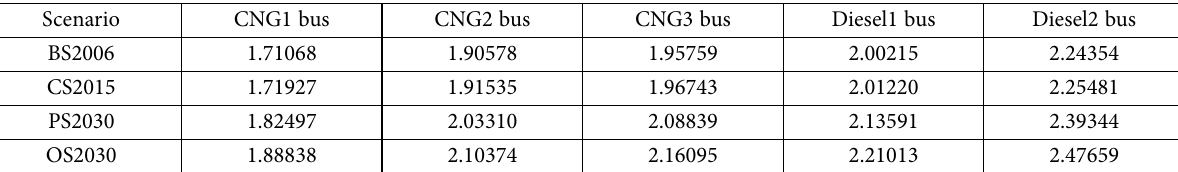
Table 7. Average external costs of CO 2 emissions per 100 bus-kms for different bus concepts according ec from to various scenarios [€/100 bus-kms, 2 CO